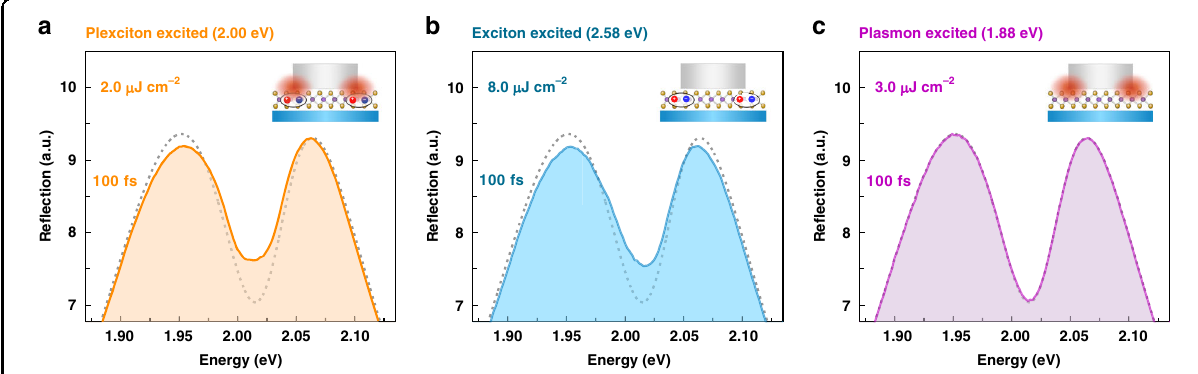
Fig. 2 Selective excitation of plasmonic/excitonic components in plexcitons. Re fl ection spectra of the Ag ND – WS 2 plexcitonic system at 100 fs time delay under ( a ) plexcitonic excitation (2.0 eV), ( b ) excitonic excitation (2.58 eV), and ( c ) plasmonic excitation (1.88 eV). To ensure the same fl uences absorbed by the sample in each pump excitation situation (roughly estimated by the value of the incident fl uence multiplied by the extinction coef fi cient), the incident fl uences for pump excitation at 2.0 eV, 2.58 eV, and 1.88 eV are tailored to be 2.0 µJ cm − 2 , 8.0 µJ cm − 2 , and 3.0 µJ cm − 2 , respectively. The grey dashed lines are the plexciton re fl ection spectrum unaffected by the pump excitation, and the inserted schematics show the components excited in the